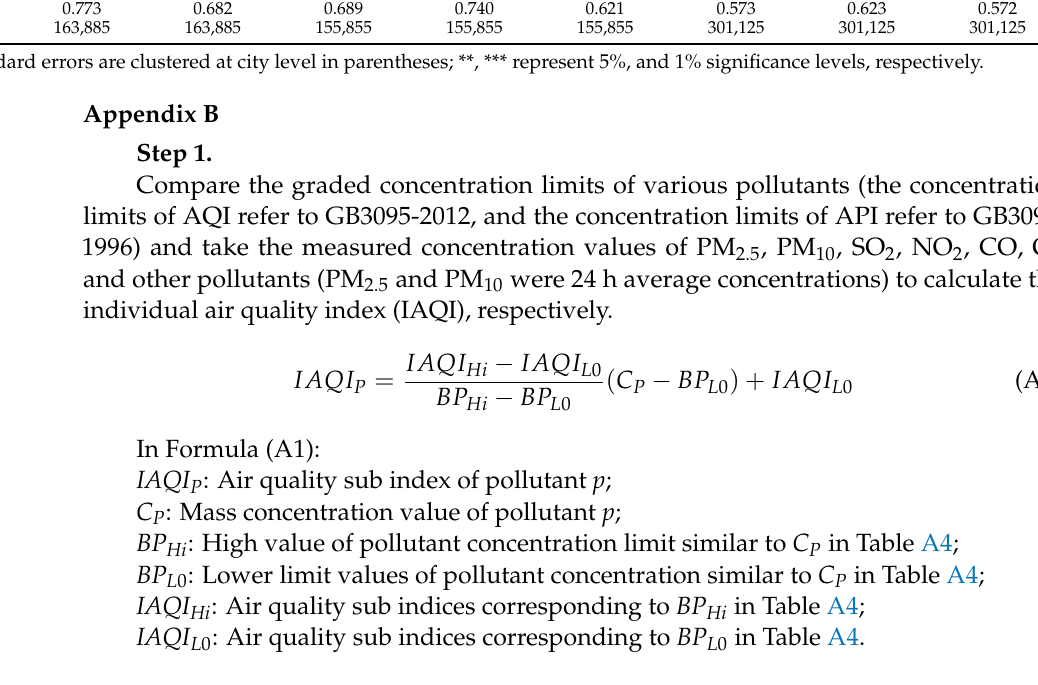
Table A4. Air quality sub index of corresponding areas and corresponding pollutant project concentration index